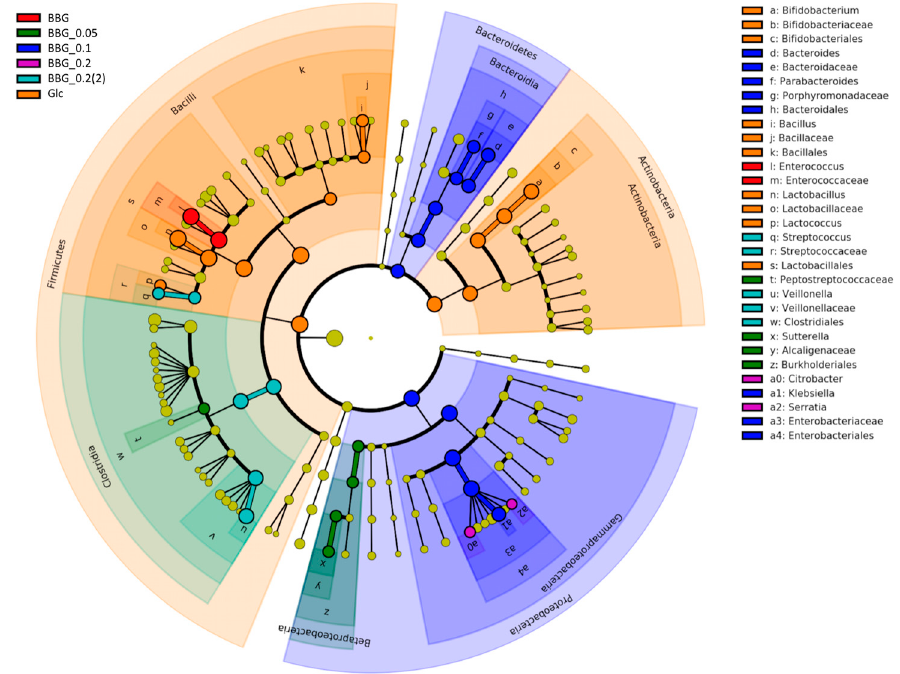
Figure 8. Cladogram of biomarkers identified in the infant faecal fermentation of 5 BBG samples against glucose monomer using LEfSe.